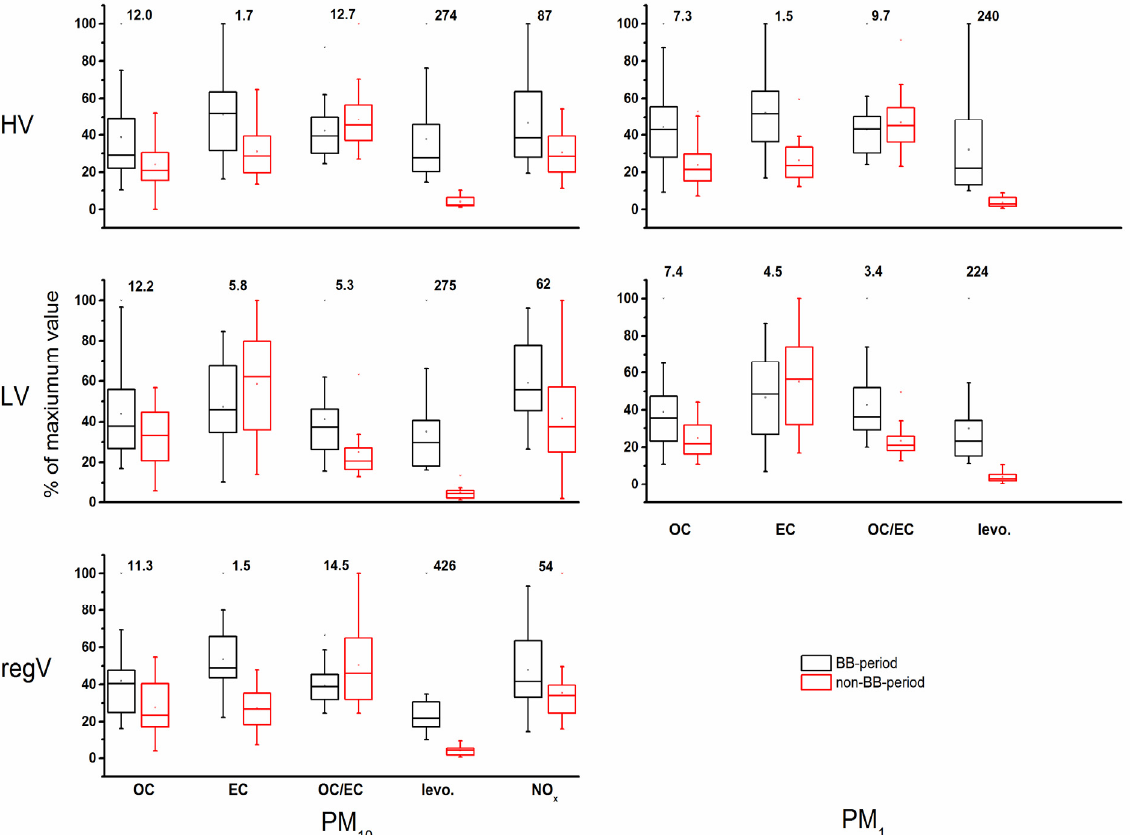
Figure 2. Concentration tendencies for OC, EC, OC/EC-ratio, levoglucosan and NO between the BB- and